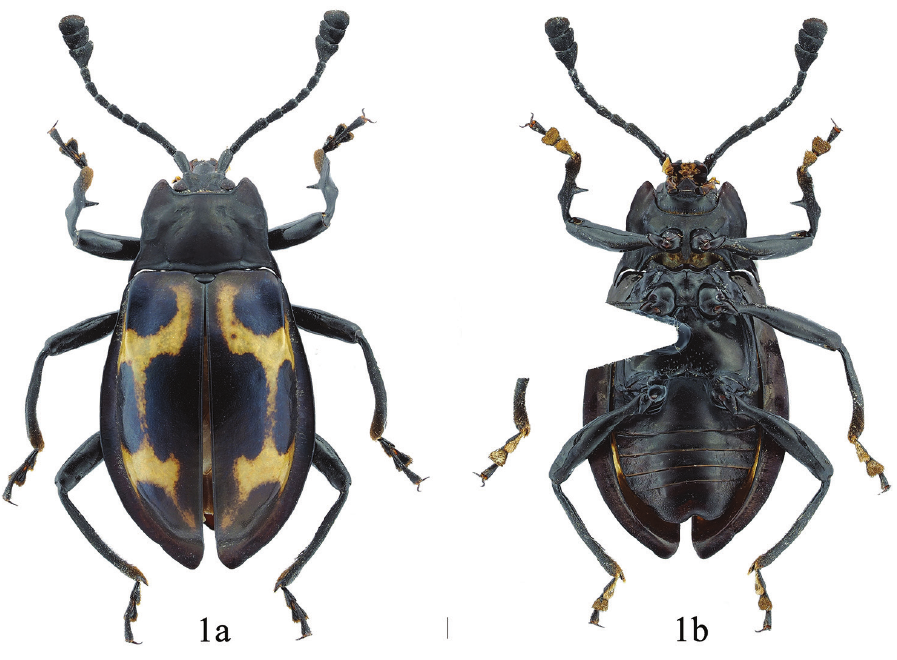
Figure 1. Dorsal and ventral habitus of E. falcifasciatus sp. n. male. a dorsal view b ventral view. Scale bar 1